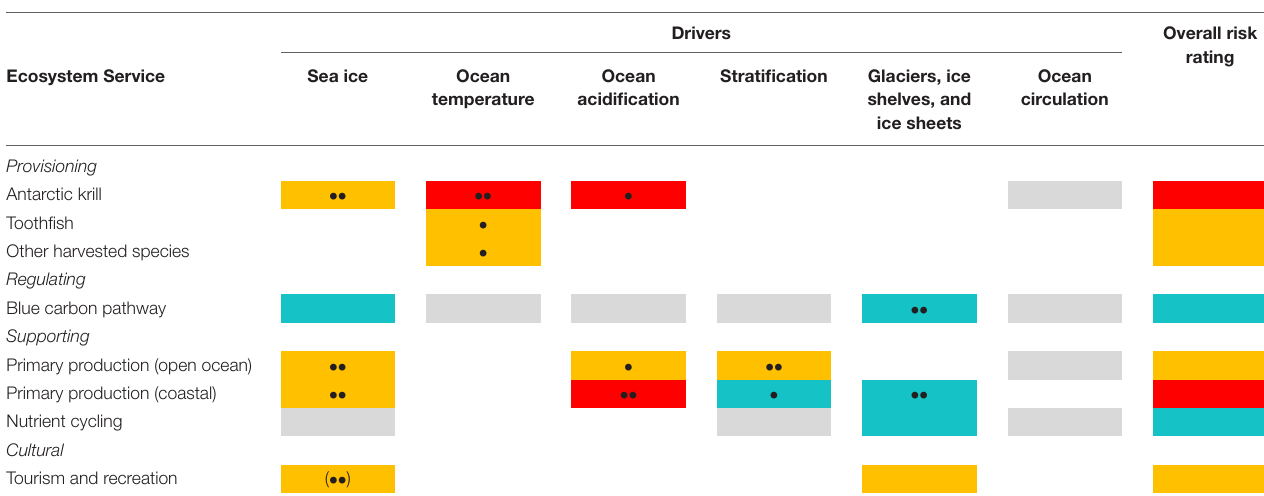
TABLE 2 | Summary risk assessment for ecosystem services (only those in Supplementary Table S2a have been